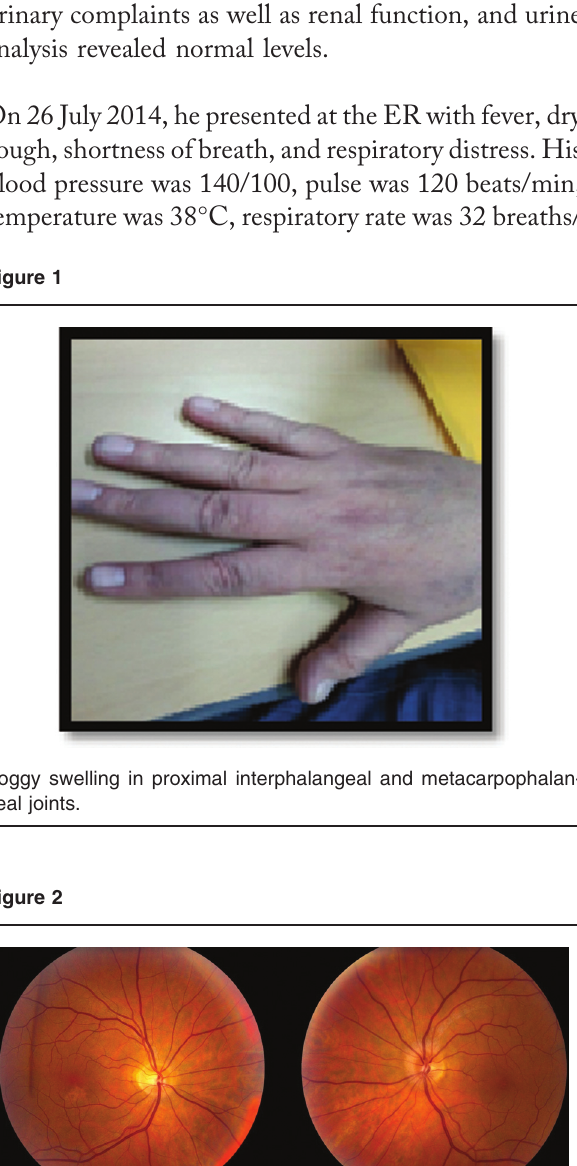
High-resolution chest computed tomography (CT) without